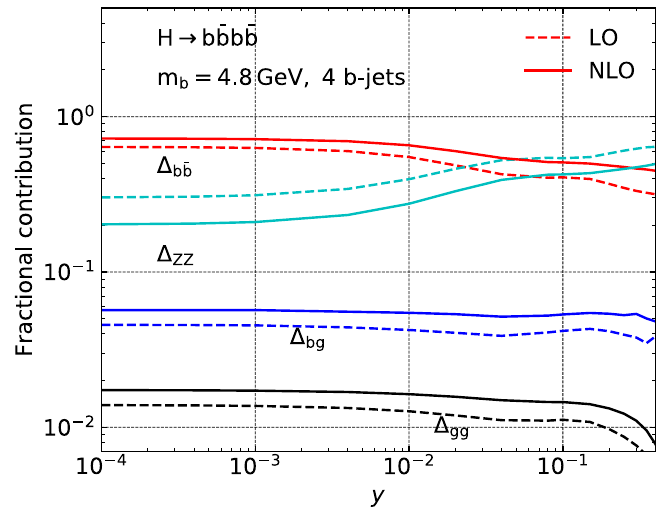
Figure 5 . Decay branching ratio of the Higgs boson to four b -jets as a function of the jet resolution parameter via either Yukawa couplings (left plot) or the electroweak couplings (right plot), at both LO and NLO.